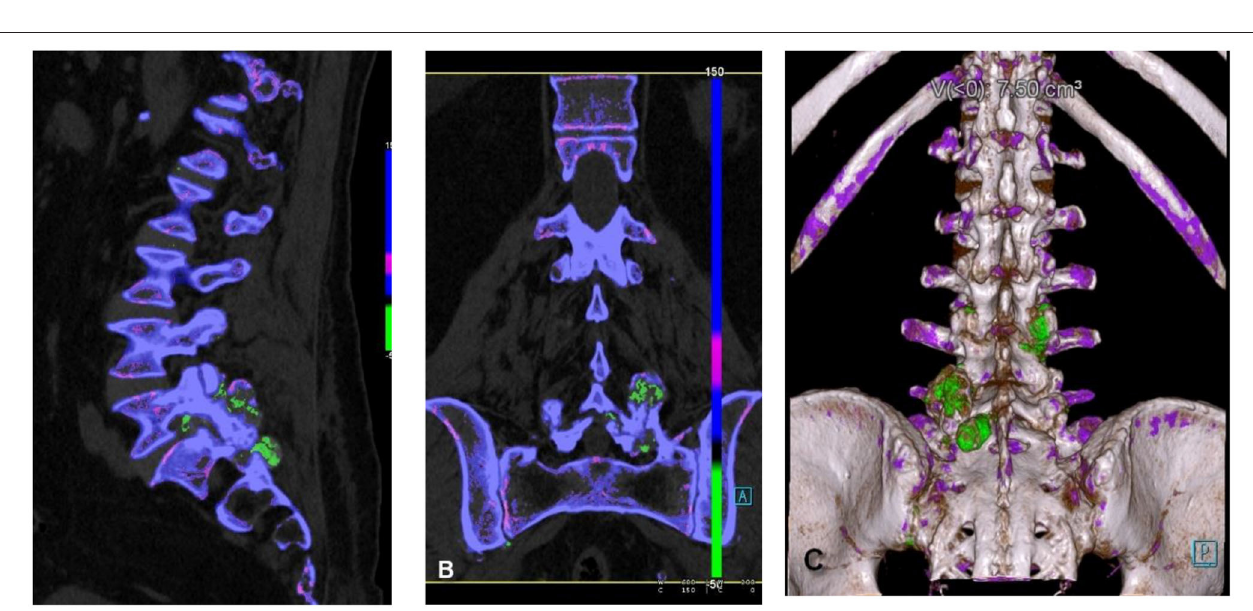
FIGURE 3 | Spinal urate deposits. (A) Sagittal reformatted, (B) coronary reformatted, and (C) 3D-rendered images demonstrating urate deposits in facet joints (green).